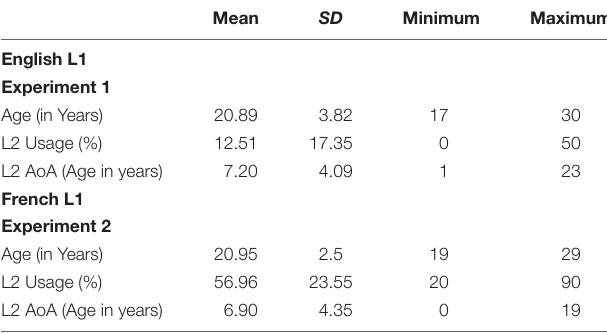
TABLE 1 | Descriptive statistics for